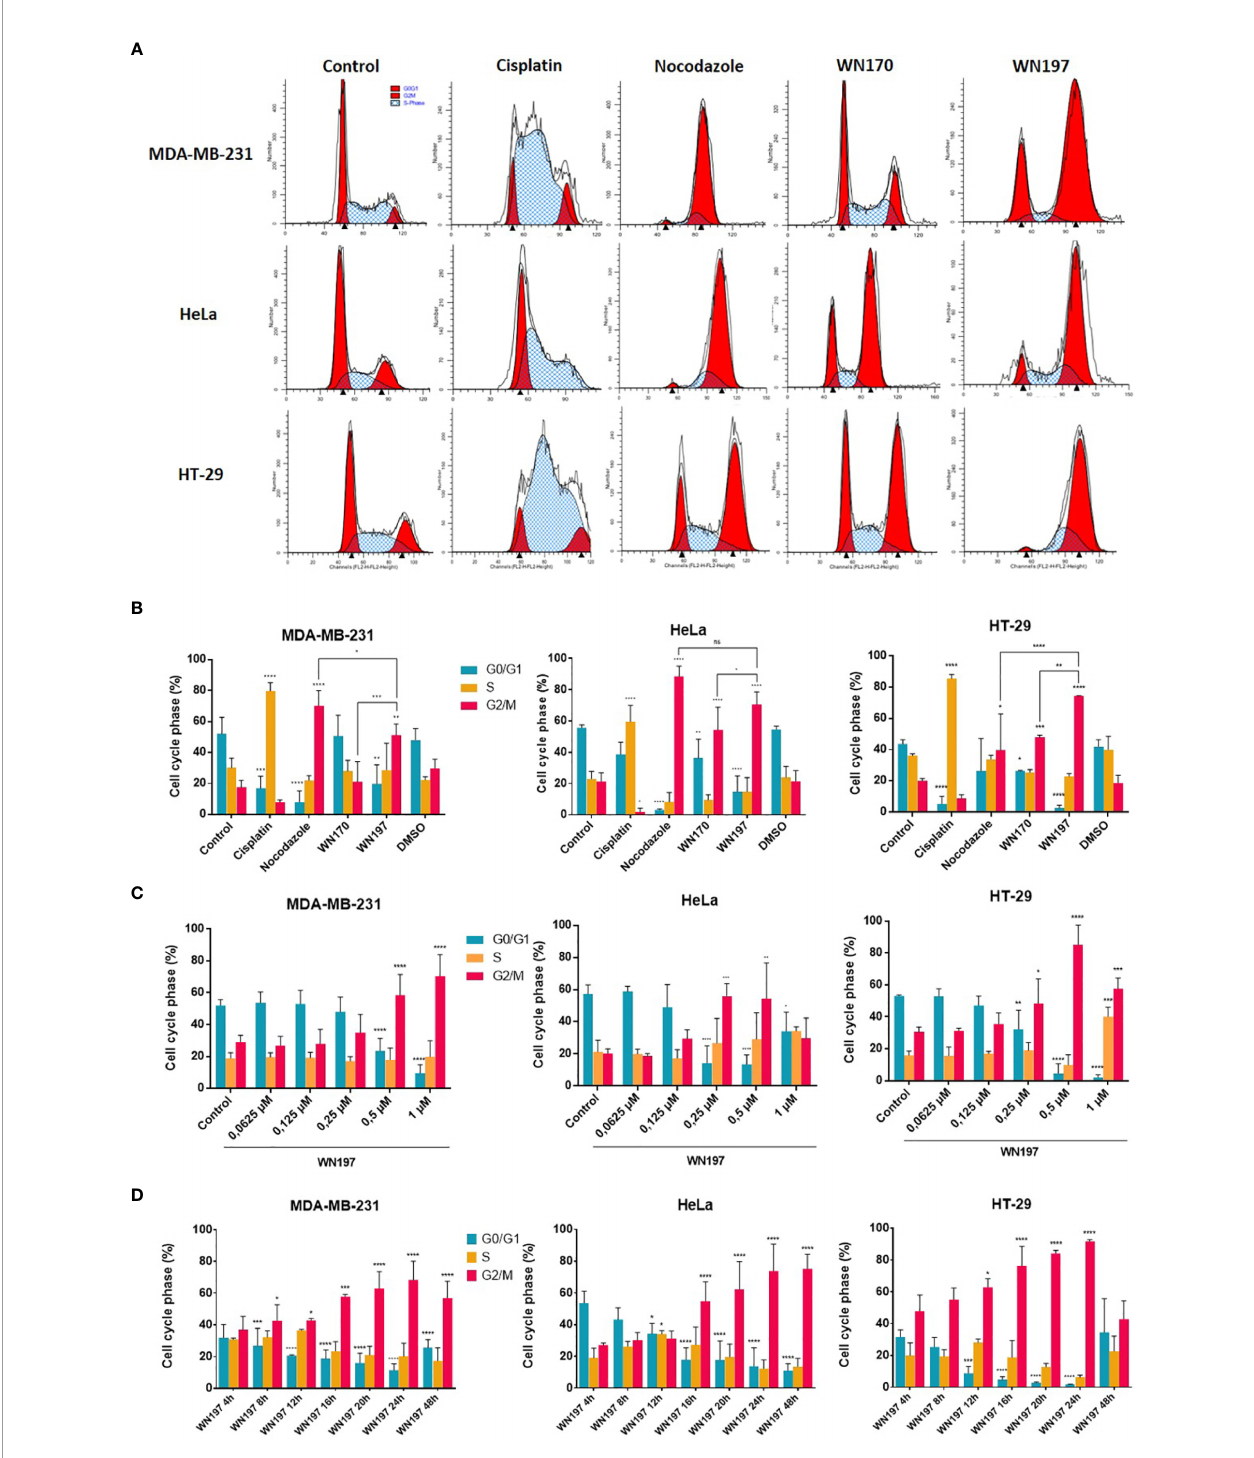
FIGURE 5 | WN197 induced cell cycle accumulation in the G2/M phase. (A) Cytograms (G0/G1 and G2/M fi rst and second peaks respectively), and (B) fl ow cytometry analysis of MDA-MB-231, HeLa, and HT-29 cells repartition in the cell cycle 24 h after treatments with cisplatin (20 µM, S phase arrest control), nocodazole (84 nM, M phase arrest control), WN170 or WN197 (0.5 µM). (C) Dose-response analysis by fl ow cytometry of G2/M phase accumulation 24 h after treatments with WN197. (D) Time course analysis by fl ow cytometry of the cell cycle repartition in cell lines untreated (control) or treated with WN197 (0.5 µM). Statistic were based on two-way ANOVA followed by Dunnett ’ s test (*p<0,05, **p<0,01, ***p<0,005 and ****p<0,001) on three independent